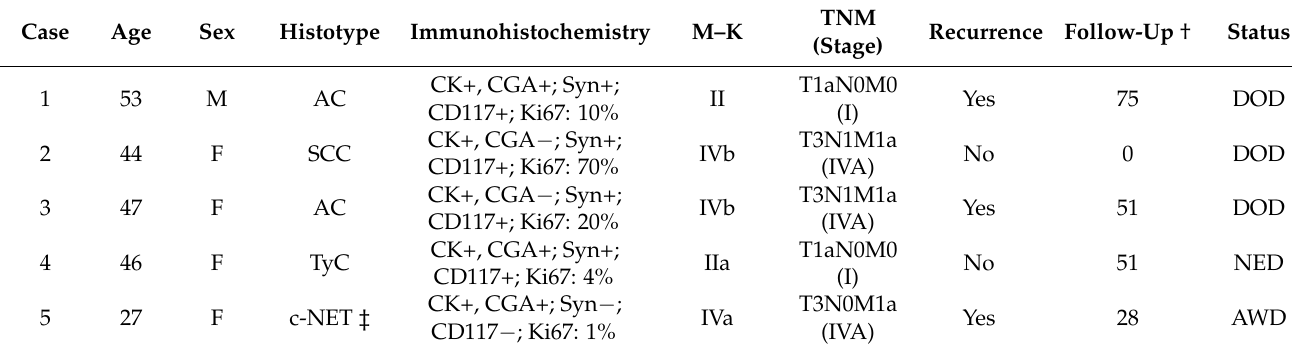
Table 3. Main clinical and histological features of five patients with TNET.